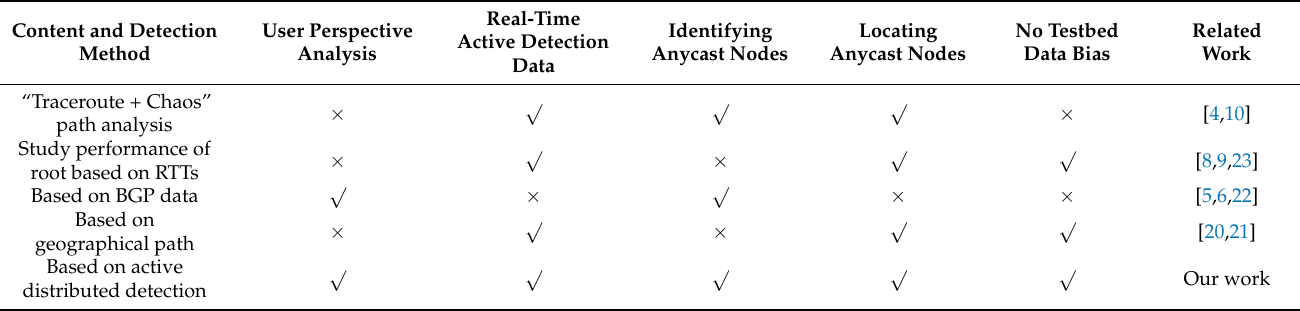
Table 1. Overview of research on the service performance of root